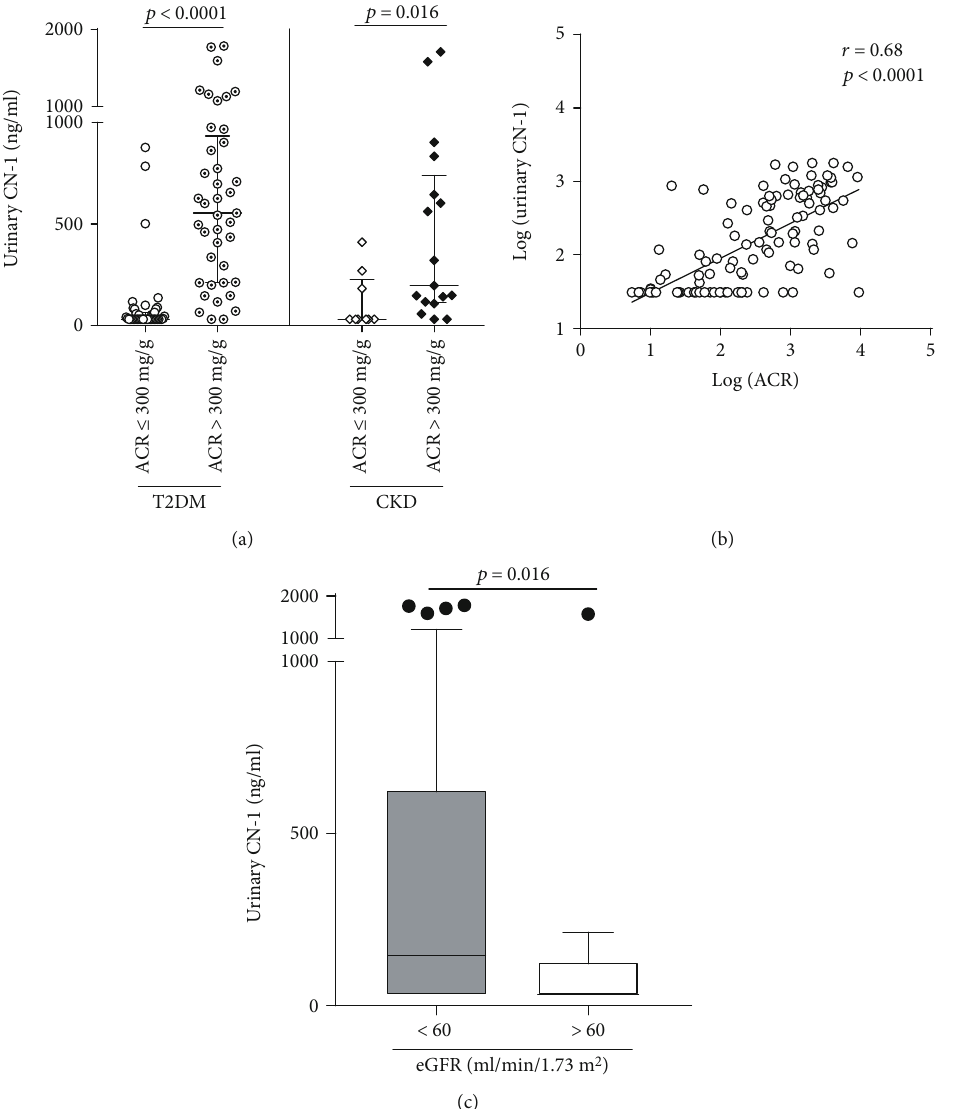
Figure 1: (a) Distribution of CN-1 in spot urine of T2DM and nondiabetic patients (CKD) with normo- or microalbuminuria ( ACR ≤ 300 mg/g ) and macroalbuminuria ( ACR > 300 mg/g ). Results for each individual patient are shown as well as the median and IQR (lines) for each of the di ff erent groups. (b) Pearson correlation between ACR [log (ACR)] and urinary CN-1 concentrations [log (urinary CN-1)] in patients with T2DM and nondiabetic CKD patients ( n = 111 ). (c) Distribution of urinary CN-1 concentrations in all patients according to eGFR. T2DM and CKD patients ( n = 111 ) were strati fi ed according to reduced ( eGFR < 60ml/min/1 : 73m 2 ) ( n = 95 ) and preserved renal function ( eGFR > 60 ml/min/1 : 73m 2 ) ( n = 16 ). eGFR was estimated using the CKD-EPI formula. Boxes and whiskers represent the median and IQR. Outliers are indicated by